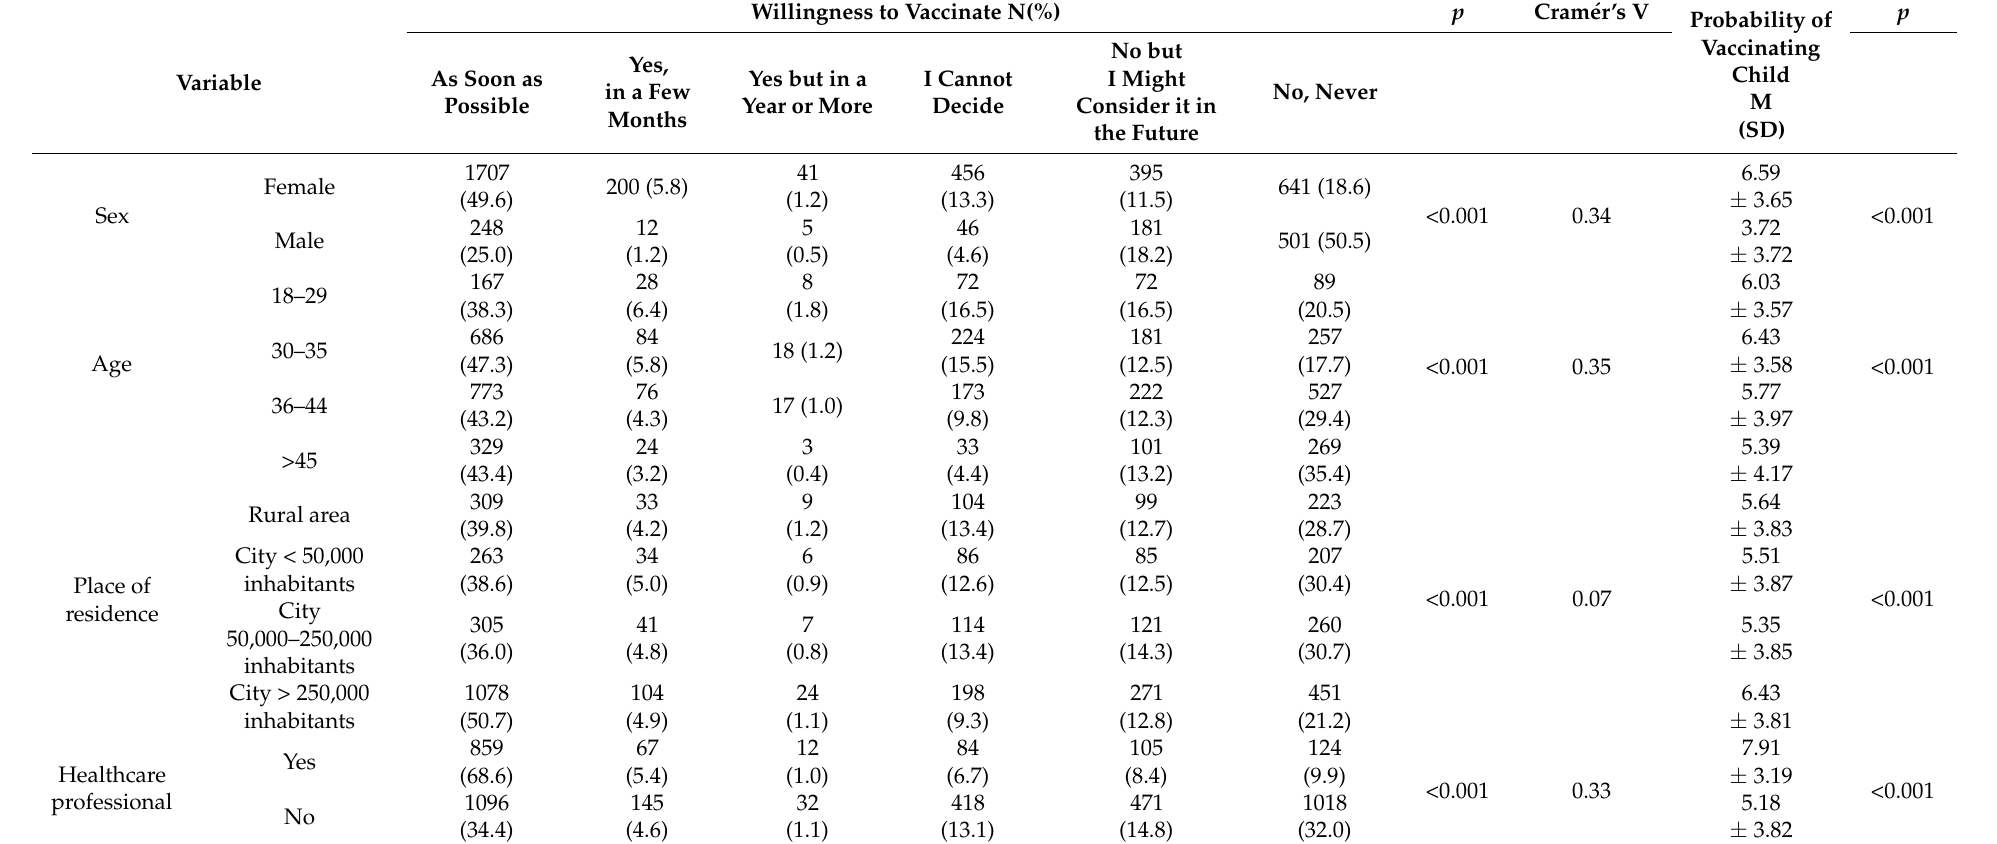
Table 4. The impact of sociodemographic factors on attitudes towards vaccinations in